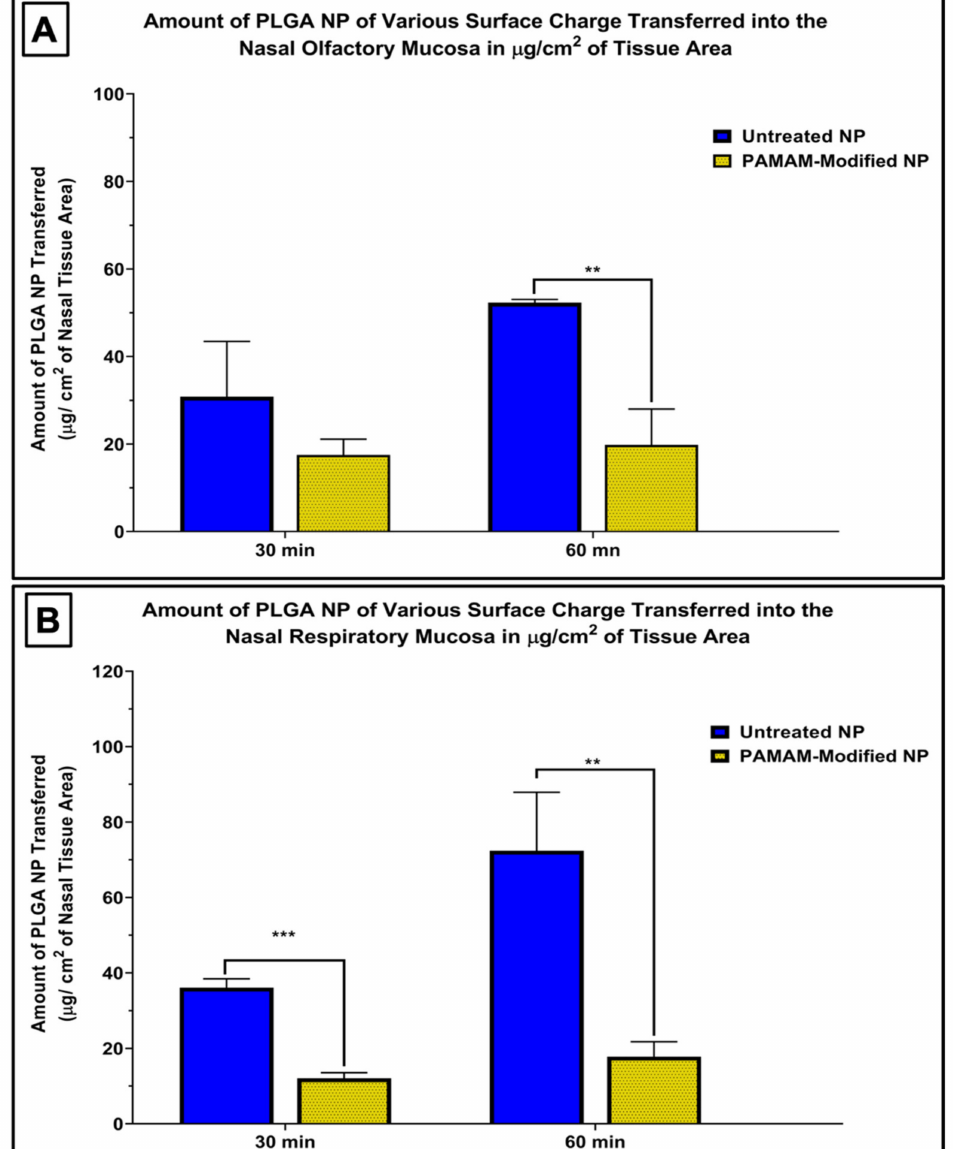
Figure 4. Effect of the addition of a polycationic polymer, polyamidoamine dendrimer (5th generation- PAMAM), on the uptake of 60 nm nanoparticles compared to unmodified, negatively charged nanoparticles in the nasal olfactory mucosa ( A ) and the nasal respiratory mucosa ( B ) normalized per tissue surface area. Nanoparticle uptake was significantly decreased in both types of mucosae after incubation with PAMAM-modified nanoparticles. The two tailed t-test was applied to evaluate the statistical significance. Bars are mean ± SD, bars represent mean ± SD, ** p < 0.005; *** p < 0.001, n = 3 each. Data for untreated nanoparticles were previously reported